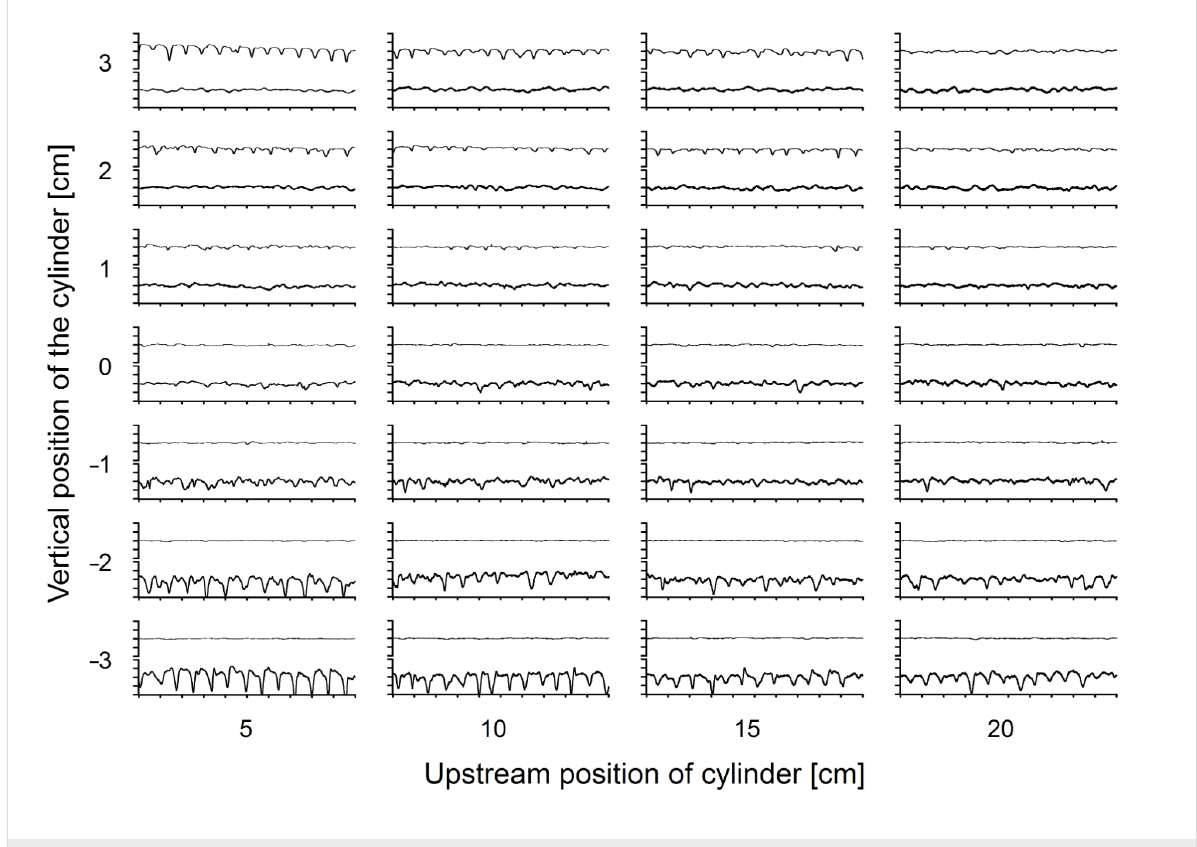
Figure 4: Responses of AN A (upper line in each graph) and AN B (lower line in each graph) (for AN A and AN B see Figure 6A) to the vortices caused by a cylinder (diameter 2 cm) placed at various positions upstream to the ALL. Note that response amplitudes decreased with increasing distance of the cylinder and that the responses were more pronounced for the AN that was ipsilateral to the cylinder.